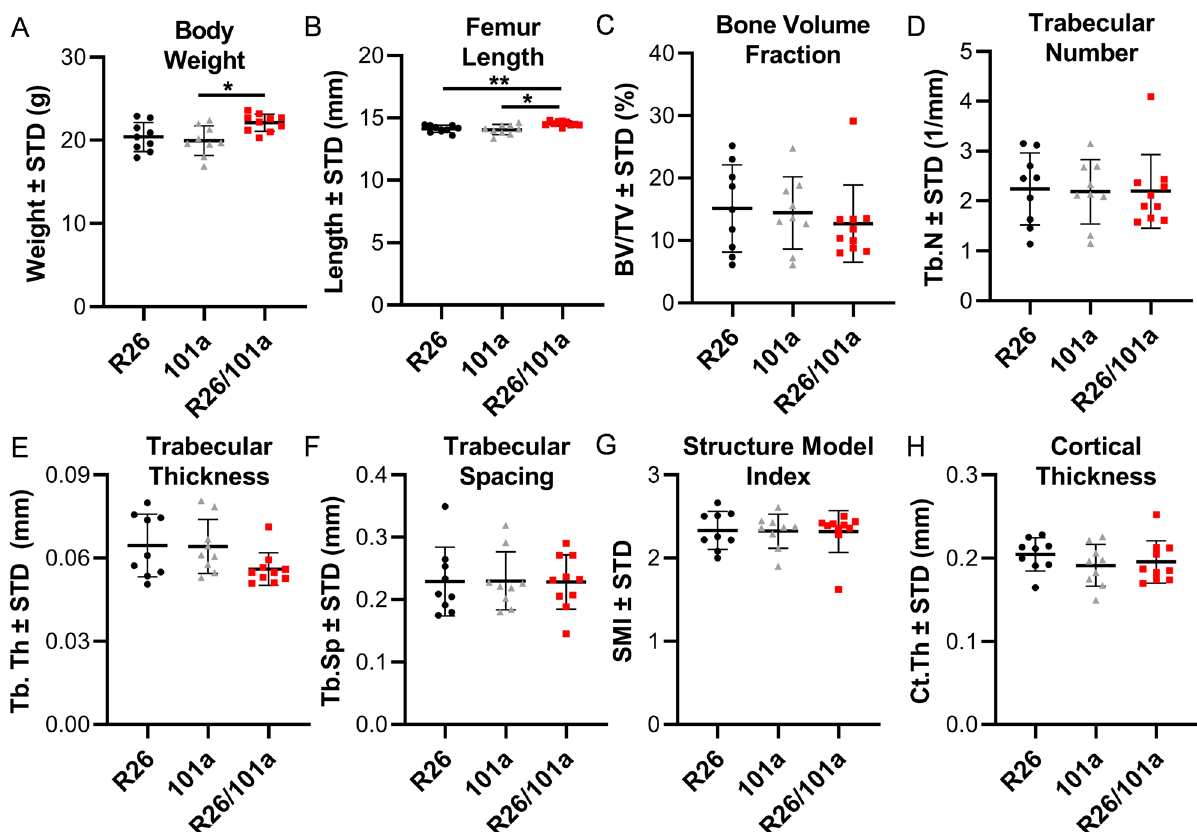
Figure 7. miR-101a over-expression does not alter bone mass in female mice. R26 control, miR-101 control, and miR-101a over-expressing (R26/101) female mice were treated with doxycycline from inception to sacrifice (8 weeks). The figure depicts body weight ( A ), femur length ( B ), trabecular bone parameters ( C–G ), and cortical thickness ( H ) as assessed by µCT (n = 9 to 10, mean ± STD). *p < 0.05 and **p <